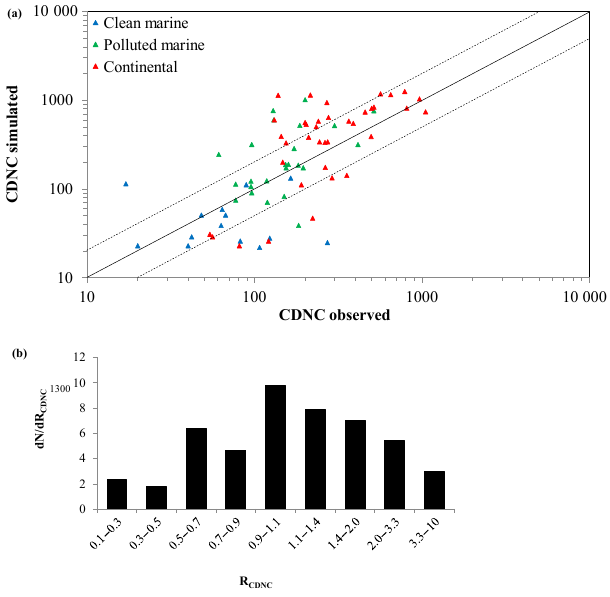
Figure 5. (a) Scatterplot comparing model simulated cloud droplet number concentrations (cm − 3 ) against 75 observational datasets worldwide, derived from in situ measurements and satellite re- trievals, also shown are the 1:1, 2:1, 1:2 lines, and (b) the prob- ability distribution of the ratio of the simulated CDNC to the ob- served CDNC ( R CDNC ) , where N is the number of occurrences in each R CDNC